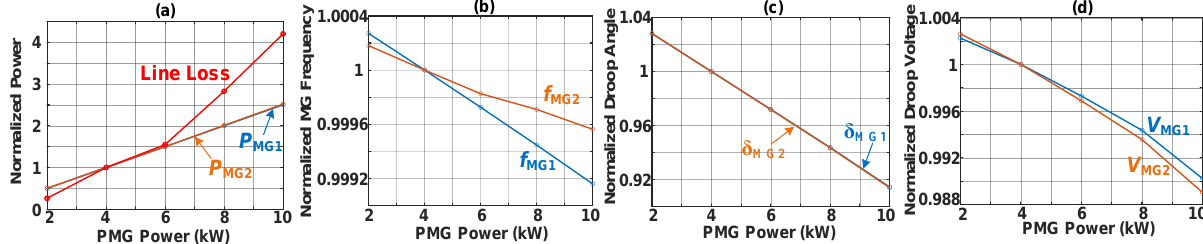
Figure 22. Sensitivity analysis with variation of PMG power demand: ( a ) line loss and power ( b ) MG frequency ( c ) line droop angle ( d ) line droop voltage.